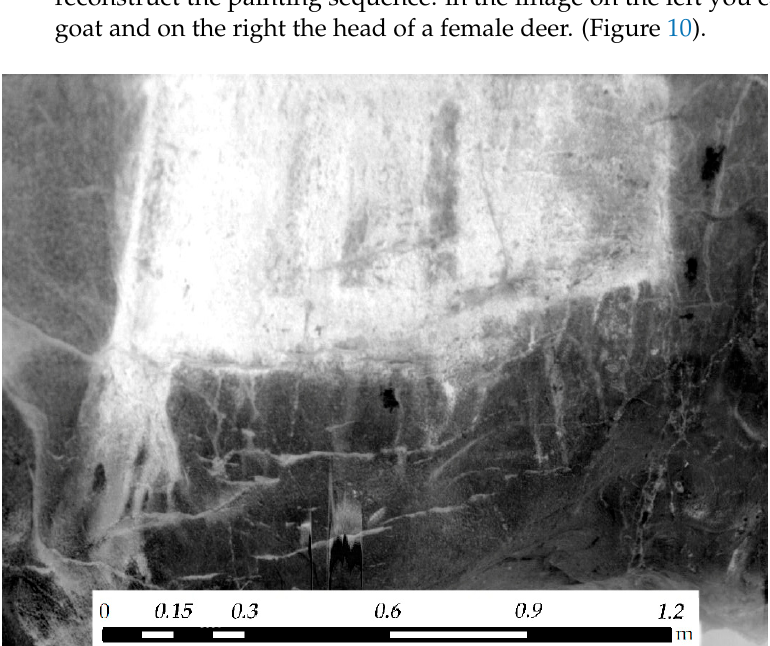
Figure 7. True color composition of hyperspectral image and location of the extension of figures. (a) represents the location of Figure 8, (b) represents the location of Figure 10.a and (c) represents the location of Figure 10.b (authorized by GIM Geomatics, S.L.).